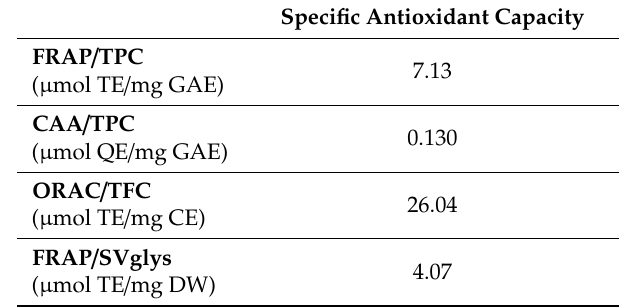
Table 3. Specific antioxidant activity measured as ratio between antioxidant activities (FRAP, ORAC and CAA) and secondary metabolites (TPC, TFC and SVglys) in stevia leaf extracts on the basis of significant and positive